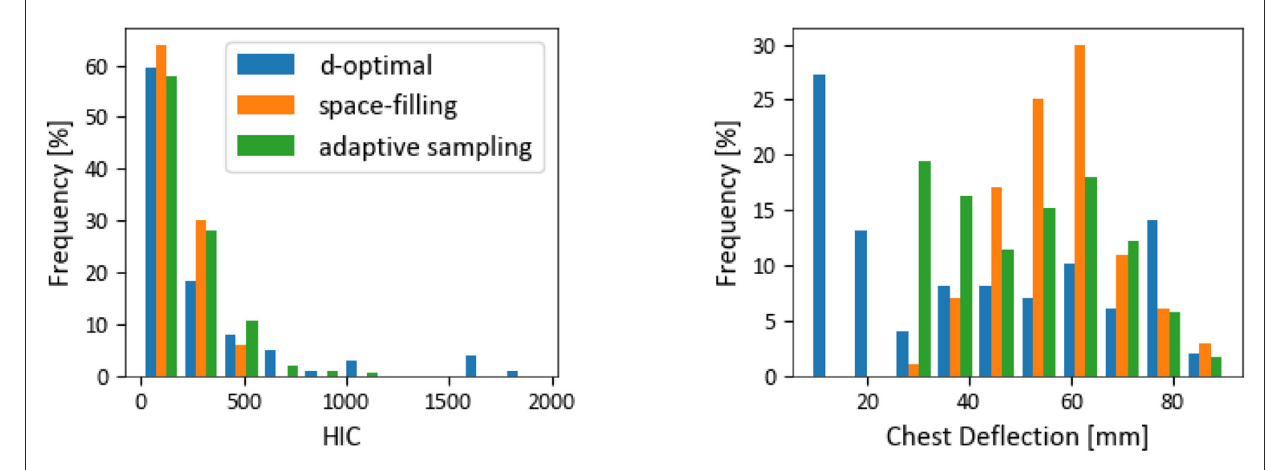
FIGURE11 Histogram of HIC 36 and chest deflection for different sampling